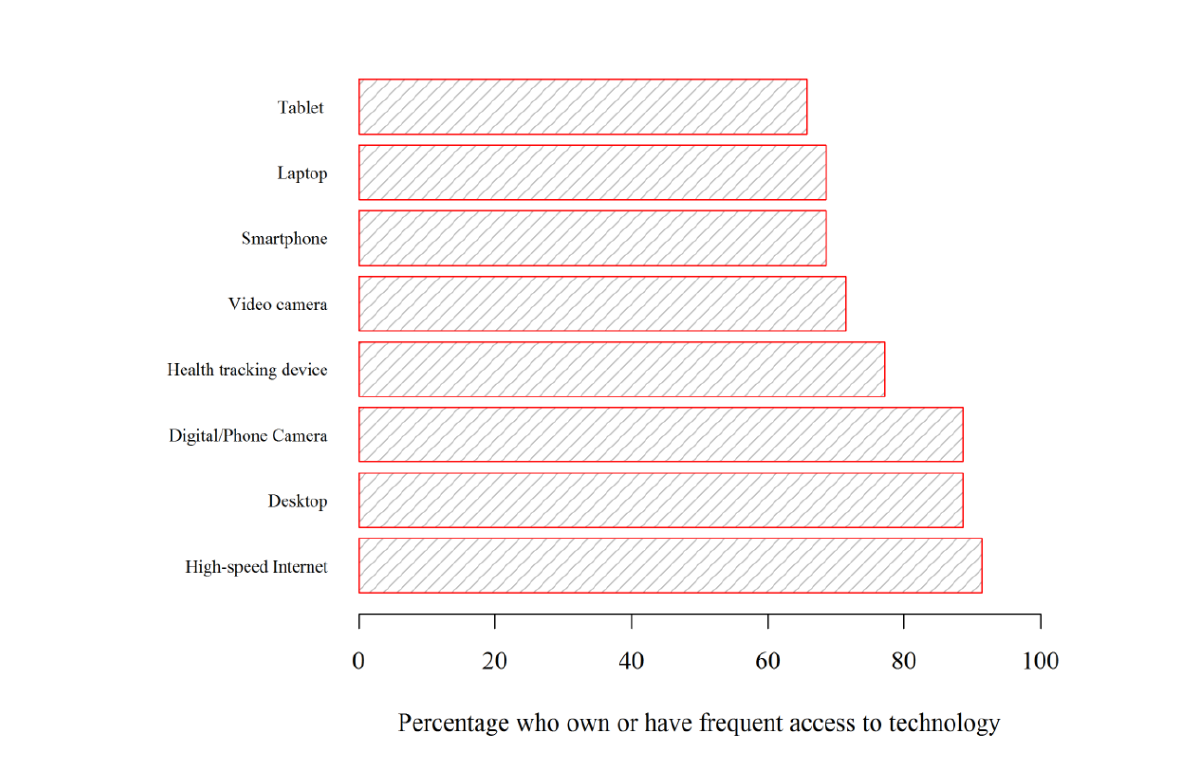
Figure 2. Access to